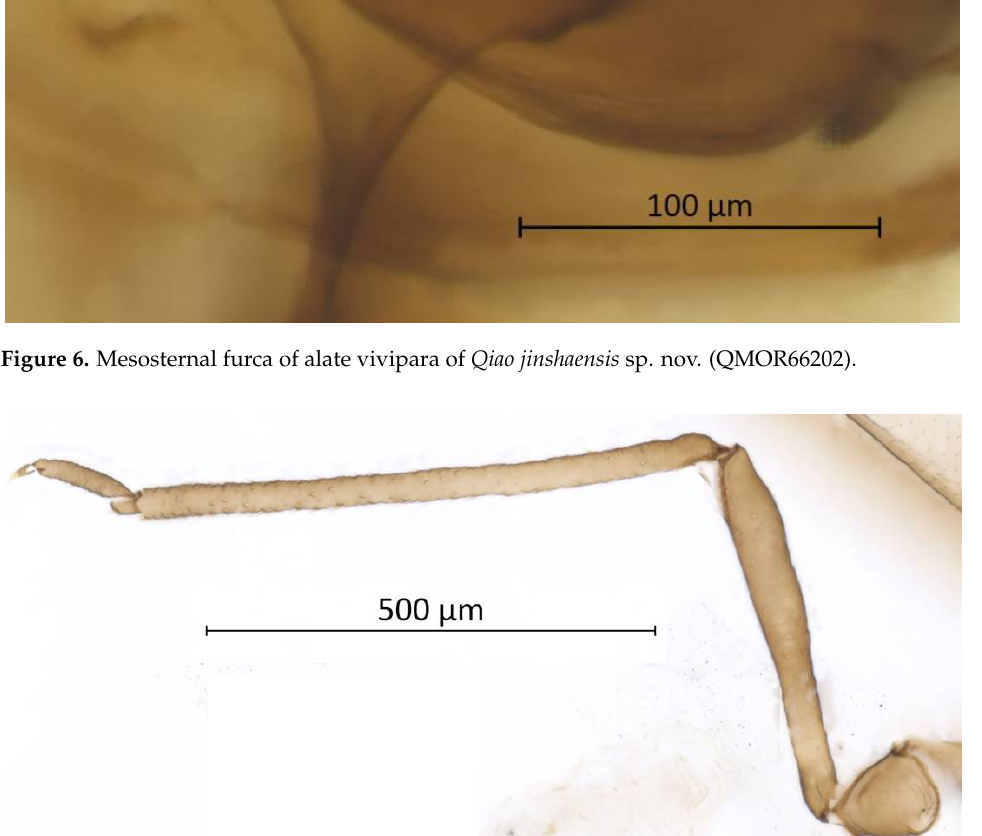
Figure 7. Hind leg of alate vivipara of Qiao jinshaensis sp. nov. (QMOR66209).